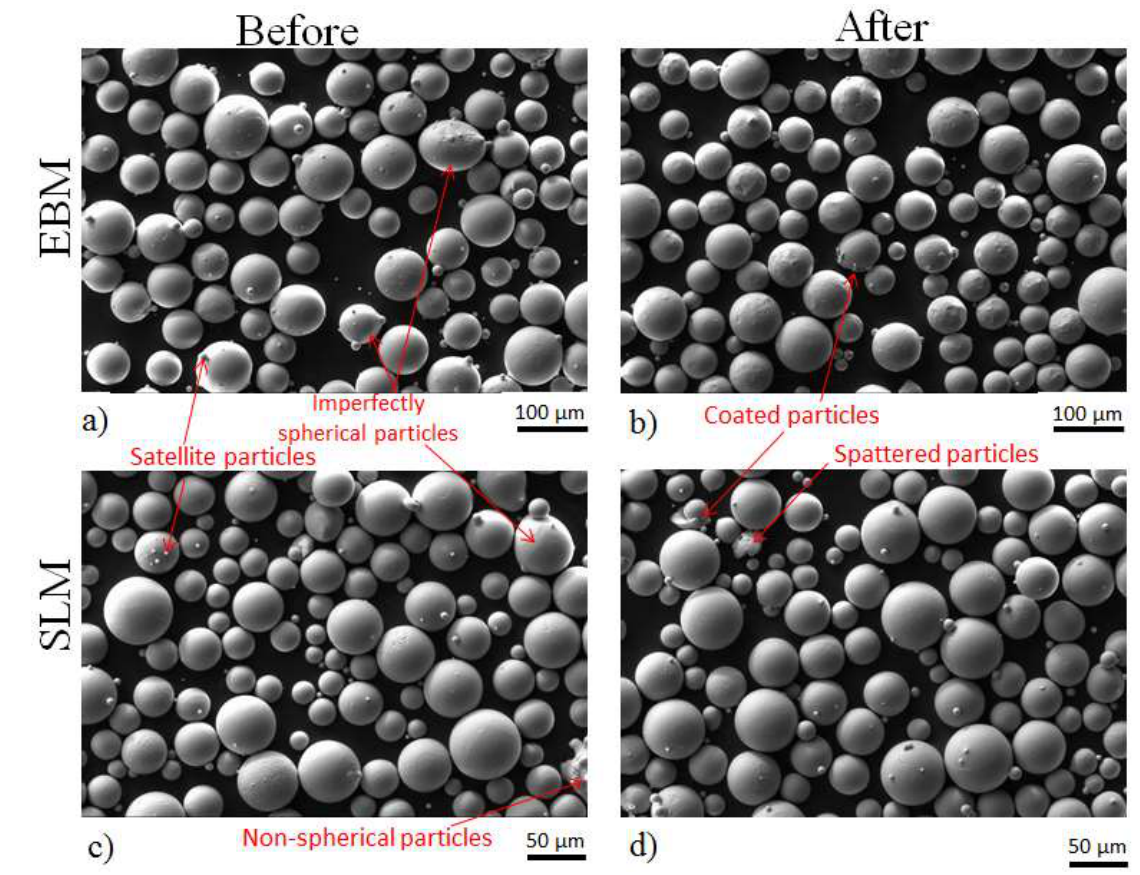
Figure 2. SEM images showing the morphologies of ingredient powder before ( a , c ) and after ( b , d ) the EBM ( a , b ) and SLM ( c , d ) processes.